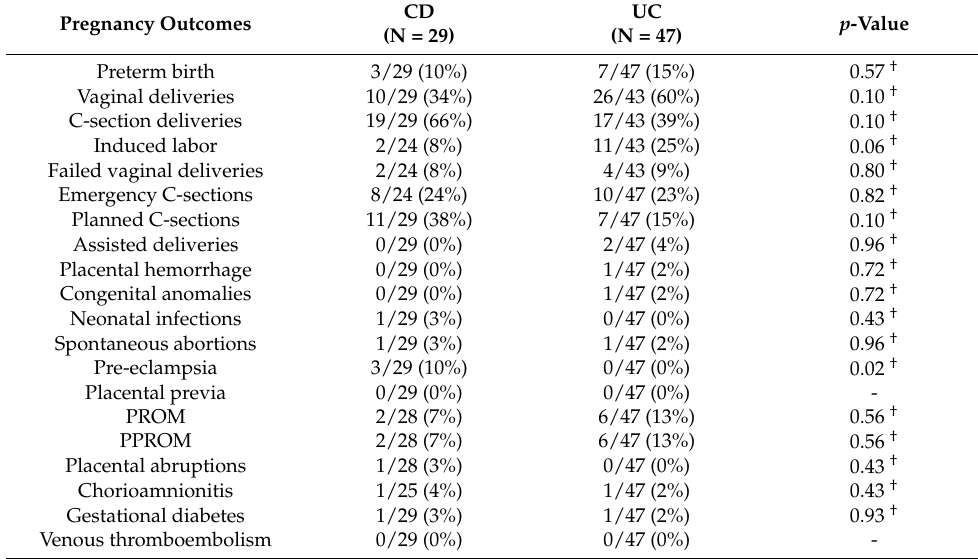
Table 2. Pregnancy outcomes by IBD